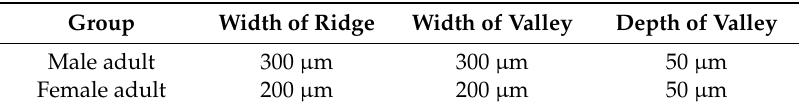
Table 1. Dimensions of the model fingerprint.